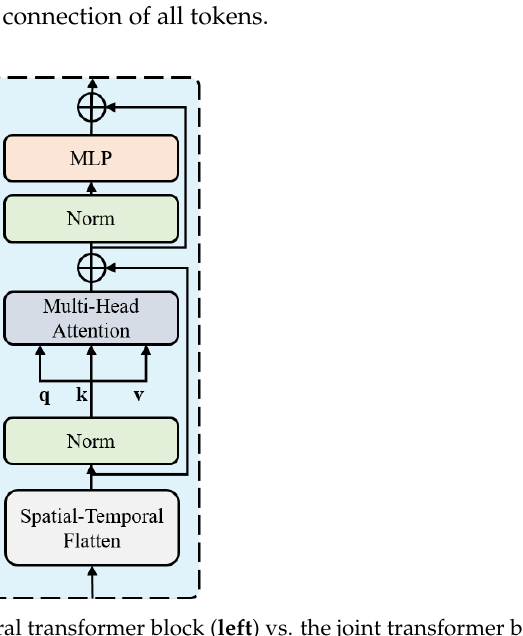
Figure 4. The spatial-temporal transformer block ( left ) vs. the joint transformer block ( right